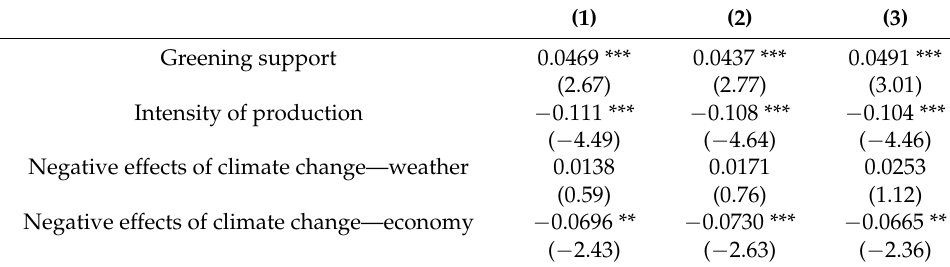
Table 2. Multivariate regression